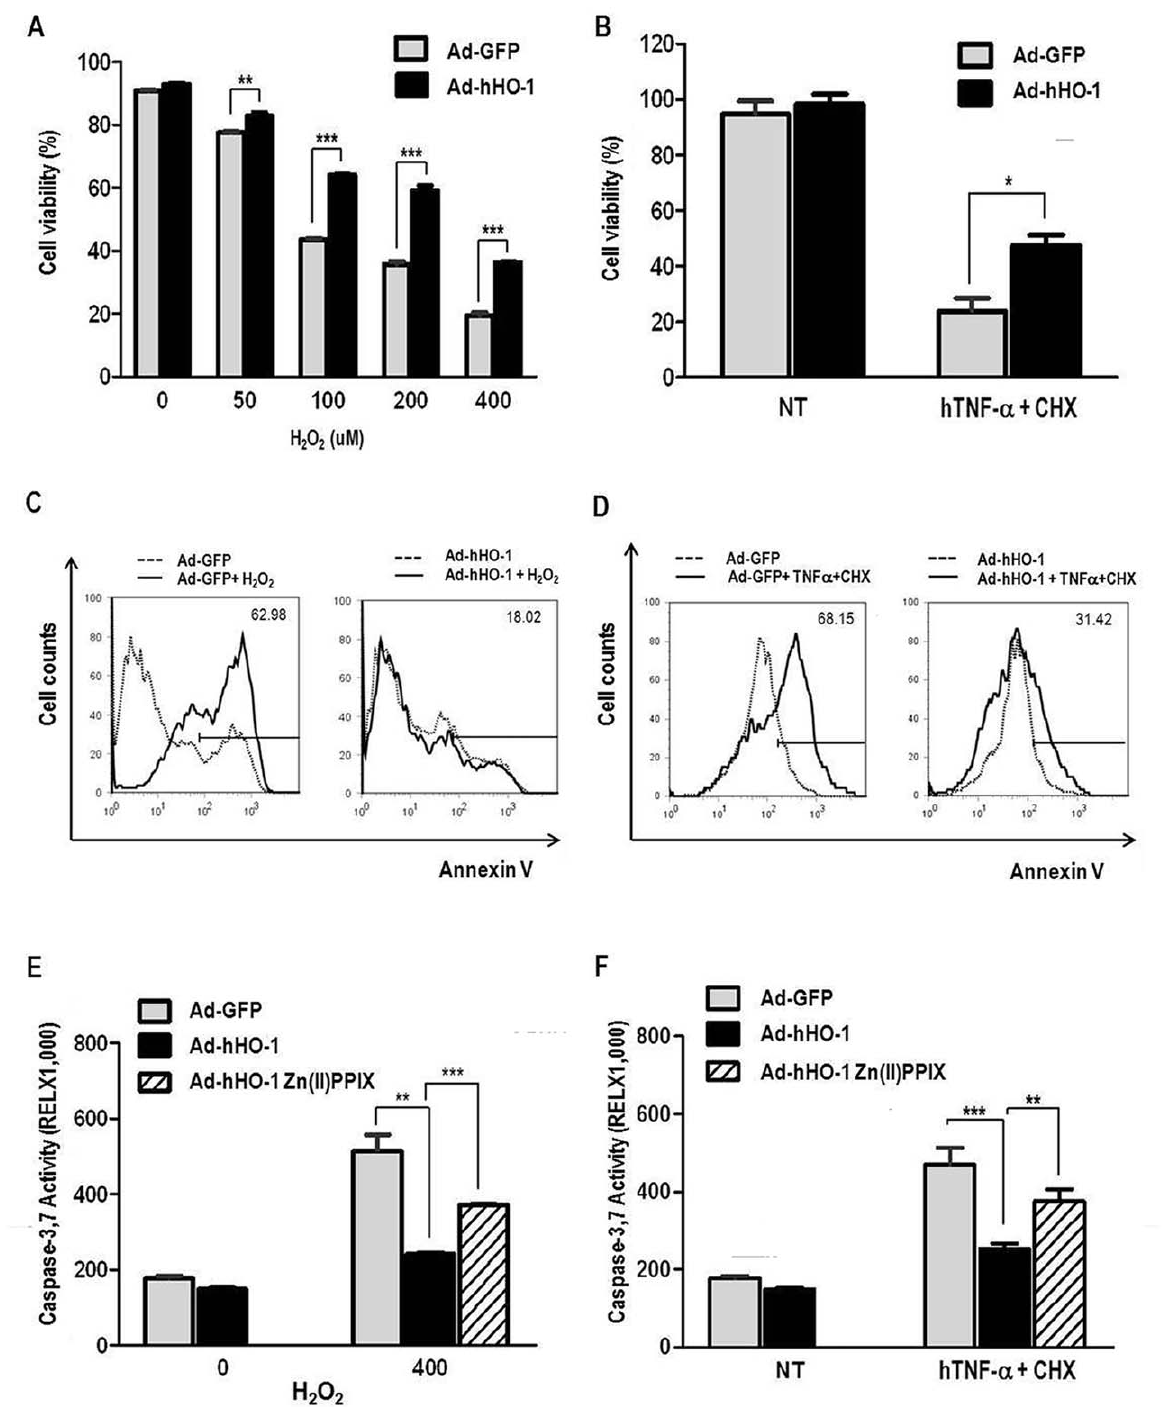
Figure 1. Impact of Ad-hHO-1 on H 2 O 2 or hTNF- a and CHX-induced cell death and apoptosis in NPCCs. A: Ad-hHO-1 increased cell viability in H 2 O 2 -treated NPCCs. NPCCs were transduced with Ad-hHO-1 for 24 hr before the addition of H 2 O 2 (0, 50, 100, 200, or 400 m M). After incubating the cells with H 2 O 2 for an additional 24 hr, cell viability was measured by CCK-8. B: After treatment with hTNF- a and CHX cell viability was measured by CCK-8. An increased proportion of viable cells were detected in the Ad-hHO-1 group compared with the Ad-GFP control group. NPCCs were infected with Ad-hHO-1 for 24 hr before the addition of hTNF- a (25 ng/ml) and CHX (10 m g/ml). After treatment with hTNF- a and CHX, the NPCCs were incubated for an additional 24 hr. C: FACS analysis of apoptosis in NPCCs after treatment with 400 m M H 2 O 2 . A lower proportion of apoptotic cells were noted in Ad-hHO-1 (50 MOI) infected NPCCs relative to the Ad-GFP control. The NPCCs were treated with H 2 O 2 (400 m M) and FACS analysis was performed using annexin V-PE. Each experiment was repeated three times (data not shown). D: FACS analysis of apoptosis in NPCCs after treatment with hTNF- a and CHX for 24 hr. A smaller proportion of apoptotic cells was detected in Ad-hHO-1 (200 MOI)-infected NPCCs than in the Ad-GFP (200 MOI) group (p , 0.05) . After treatment with hTNF- a and CHX, apoptosis of cultured NPCCs was measured by FACS using annexin V. The numbers indicate the proportion of apoptotic cells in the NPCCs after 24 hr of incubation with hTNF- a and CHX. E: Lower activity of